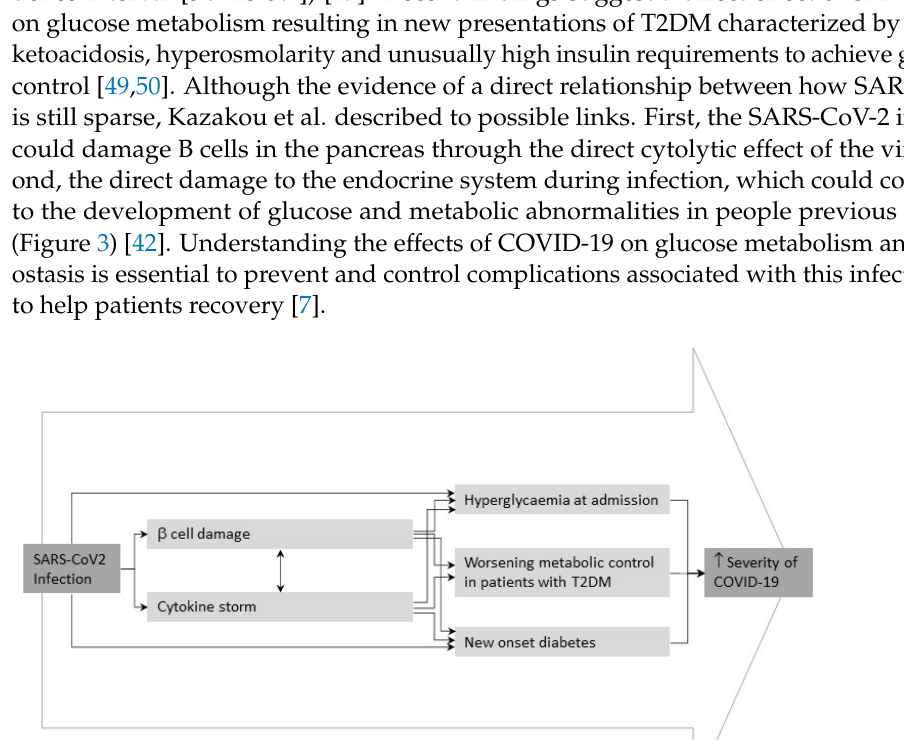
Table 2. Beneficial and adverse effects and clinical recommendations of antidiabetic treatment for COVID-19.